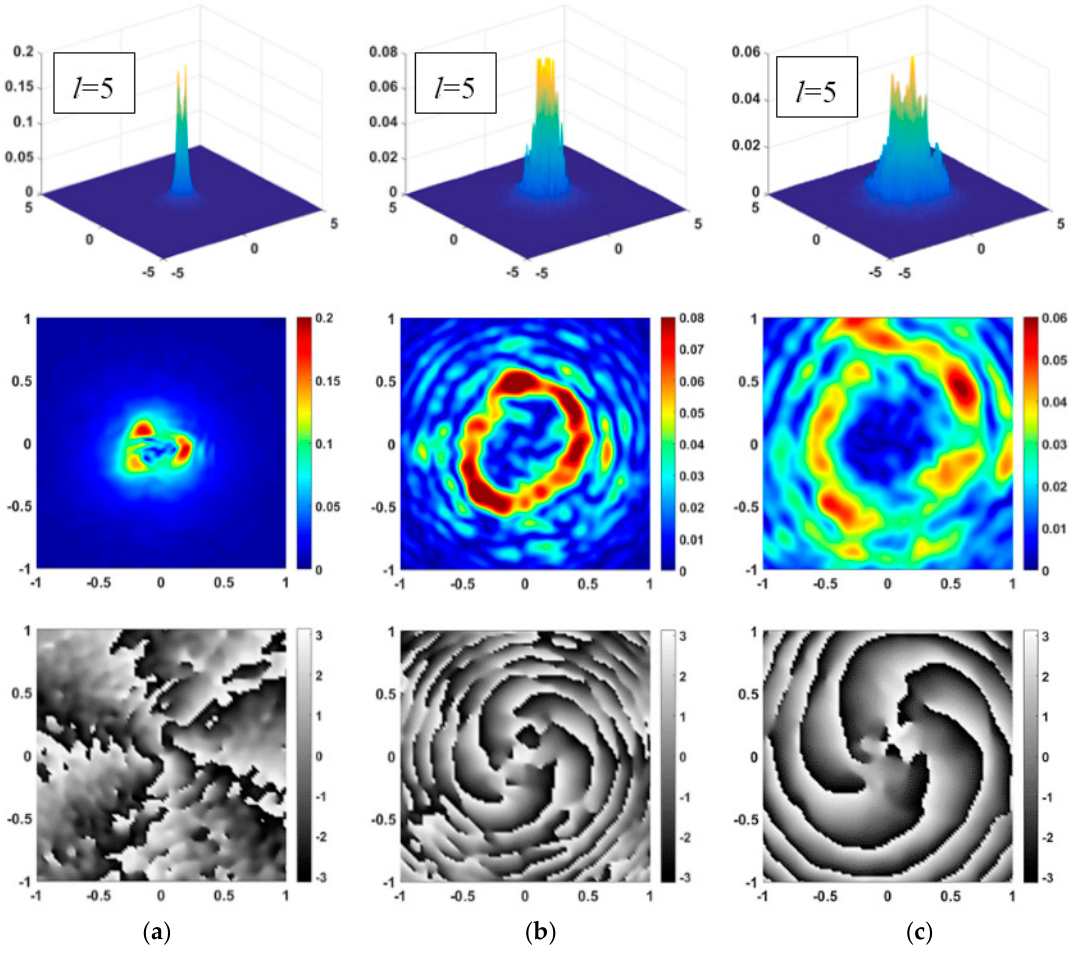
Figure 3. Intensity and phase distribution of electromagnetic vortex waves with the transmission distance ( a ) 1 km, ( b ) 5 km and ( c ) 10 km under moderate-to-strong turbulence conditions.